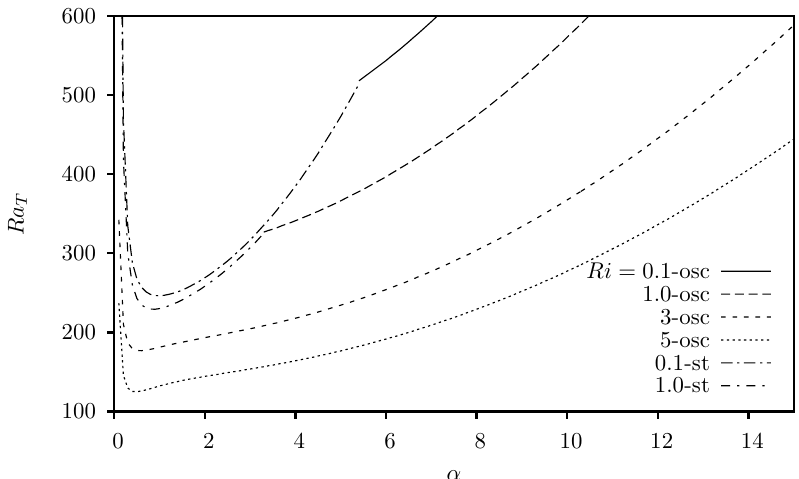
Figure 4. Effect of R i on the marginal stability curves for stationary and oscillatory convection with respect to the wave number α .